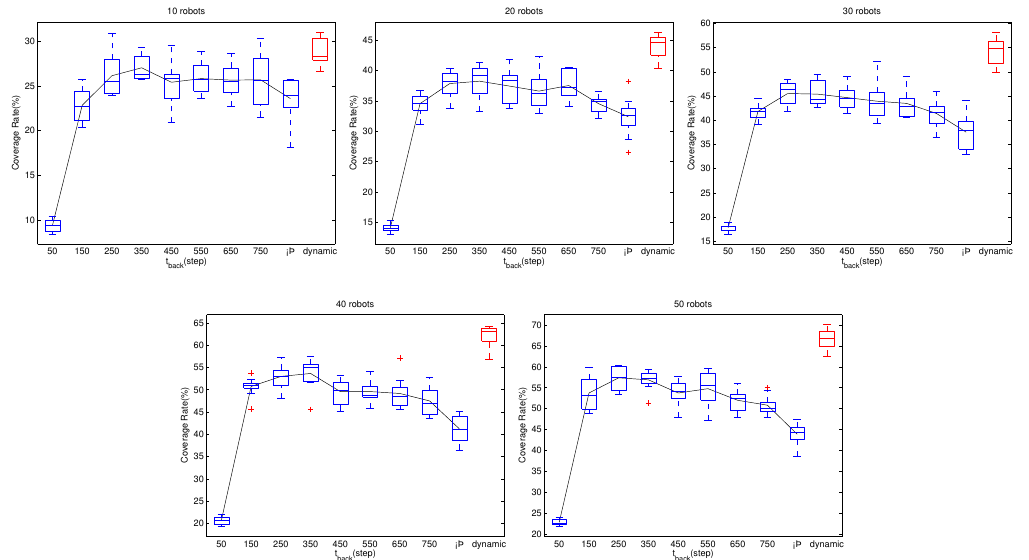
Figure 8. The effects of t back on behavior law f local . Each subfigure illustrates the variation of the swarm’s performance with the increase of t back when using a fixed number of robots. The robot numbers are 10, 20, 30, 40, and 50, respectively. The t back increases from 50 to 150, 250, 350, 450, 550, 650, 750, and ∞ . With ∞ , it means that the robots never visit the communication network. The red box shows the coverage rate with the method in Section 5.2 that adjusts t back automatically. The black line links the mean values of the coverage rate, showing how the performance changes with the increase of t back . From the black line, we notice that, with the increase of t back , the performance first increases and then decreases. There exists a best t back which provides the fastest coverage rate. However, as analyzed in Section 5.2, we are unable to obtain this value directly. Meanwhile, the red box shows that, with the dynamic adjust t back strategy, the performance is superior to that of any fixed t back . The phenomenon appears in each subfigure, i.e., simulation with different swarm size, indicating that, when using f local , the dynamic adjust t back scheme performs better than any fixed t back